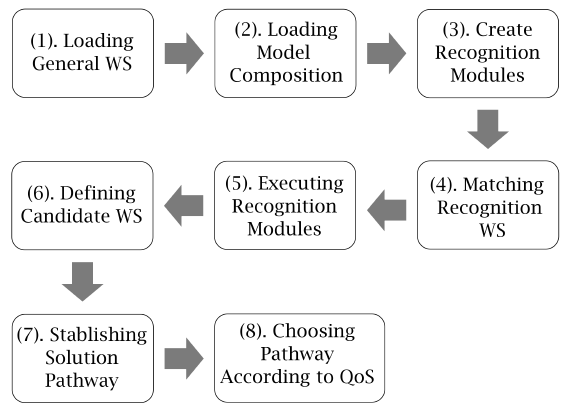
Figure 4. Ar_WSDS